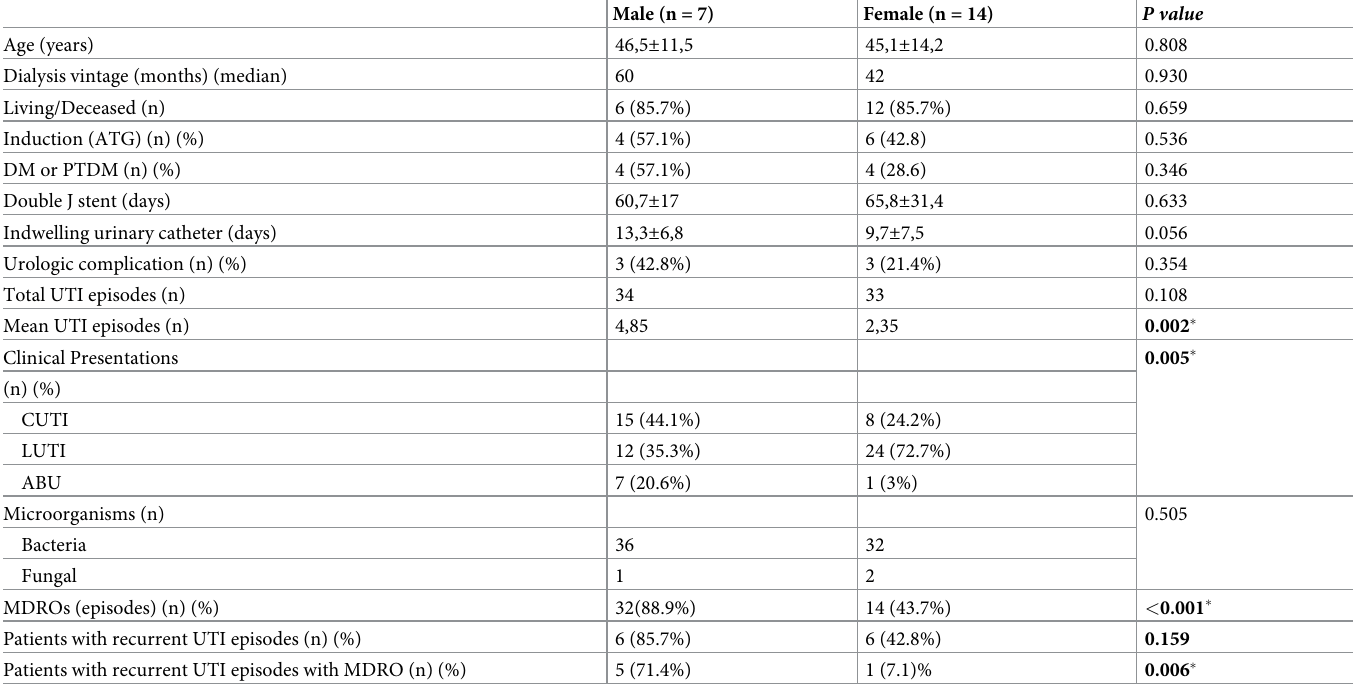
Table 5. Comparison of male and female patients with